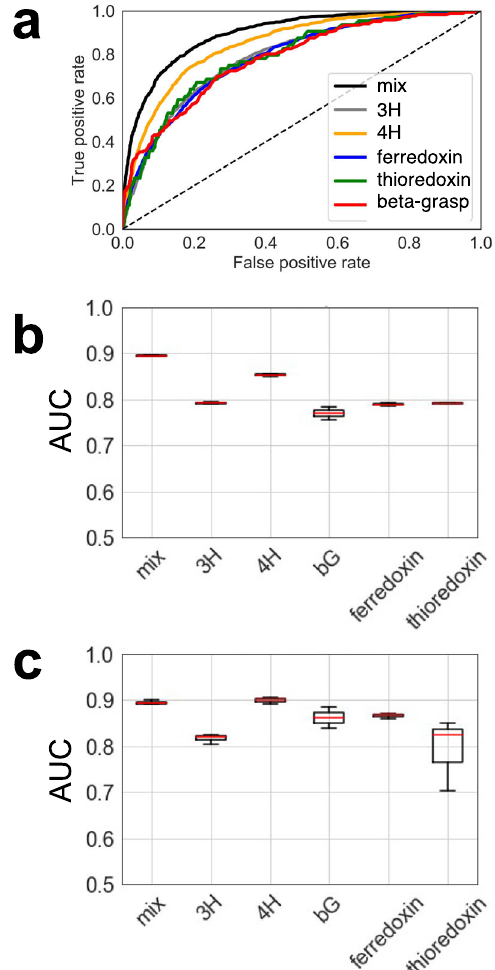
Fig.5|Performanceofthestabilitypredictionclassi fi er.a Thereceiveroperator curve (ROC) illustrates the predictive power of our Random Forest classi fi er. To avoidpotentialbias, we comparedthe ROC ofpredicting stabilitiesforany protein within the whole set vs. a ROC of the different folds or all combined (mix) after trainingontheotherfoldswithintheset.Forthisprediction,onefoldatatimewas omitted ( “ dropout ” ), and the classi fi er was trained on all other folds to predict the stabilityofthe unseenfold. b AUCs of threeiterations of the predictionsdescribed under (A); This graph represents the minimum, maximum, and median in the data set. c Summary of AUCs of predictions for individual folds. Boxplots describe the spread of data after three independent training and predictions, showing mini- mum, maximum, and median. Source data is provided as Source Data